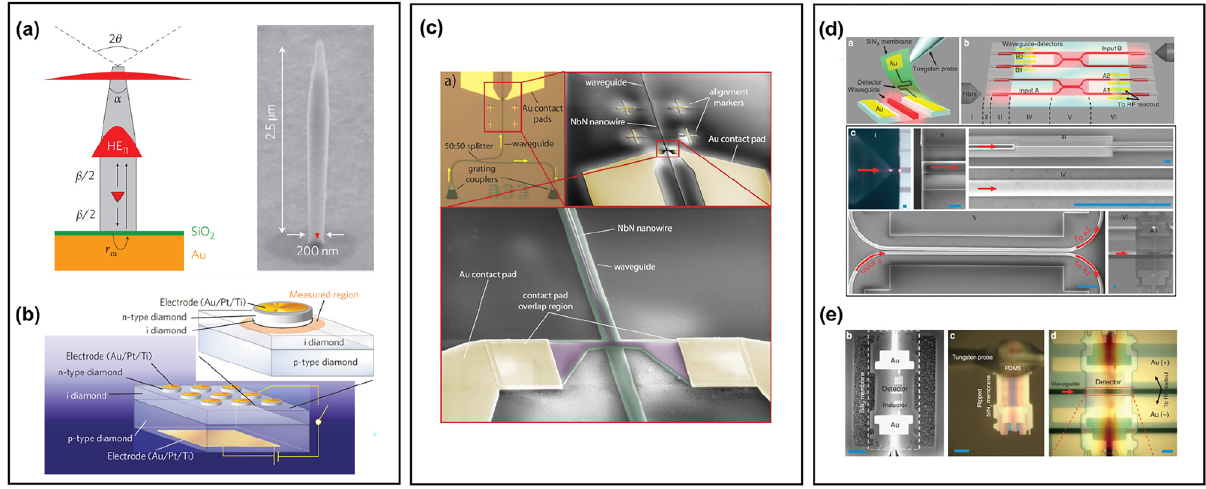
Figure7: On-chipquantumphotonics.(a)Single-photonsourcegeometry.AnInAsQD(redtriangle)isembeddedinaGaAsphotonicnanowire andSEMimageofatypicaldevice(reproducedfrom[94]).(b)Schematicdiagramofthesingle-photon-emittingdiodeofdiamond(reproduced from[95]).(c)Opticalmicroscopeimageof ananophotonic circuitwithon-chipSNSPDdevice.Inset:SEMmicrographof thedetectorareawith metal alignment mark and zoomed waveguide region with NbN nanowire atop (reproduced from [96]). (d) Assembly of high-system-ef fi